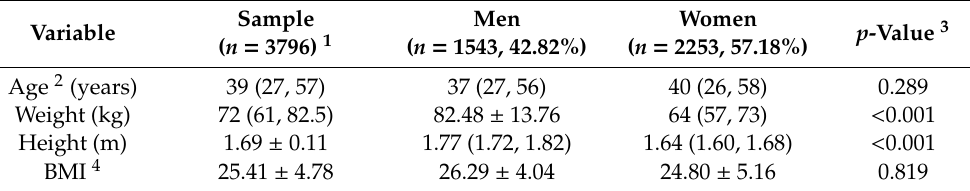
Table 2. Anthropometric variables of the